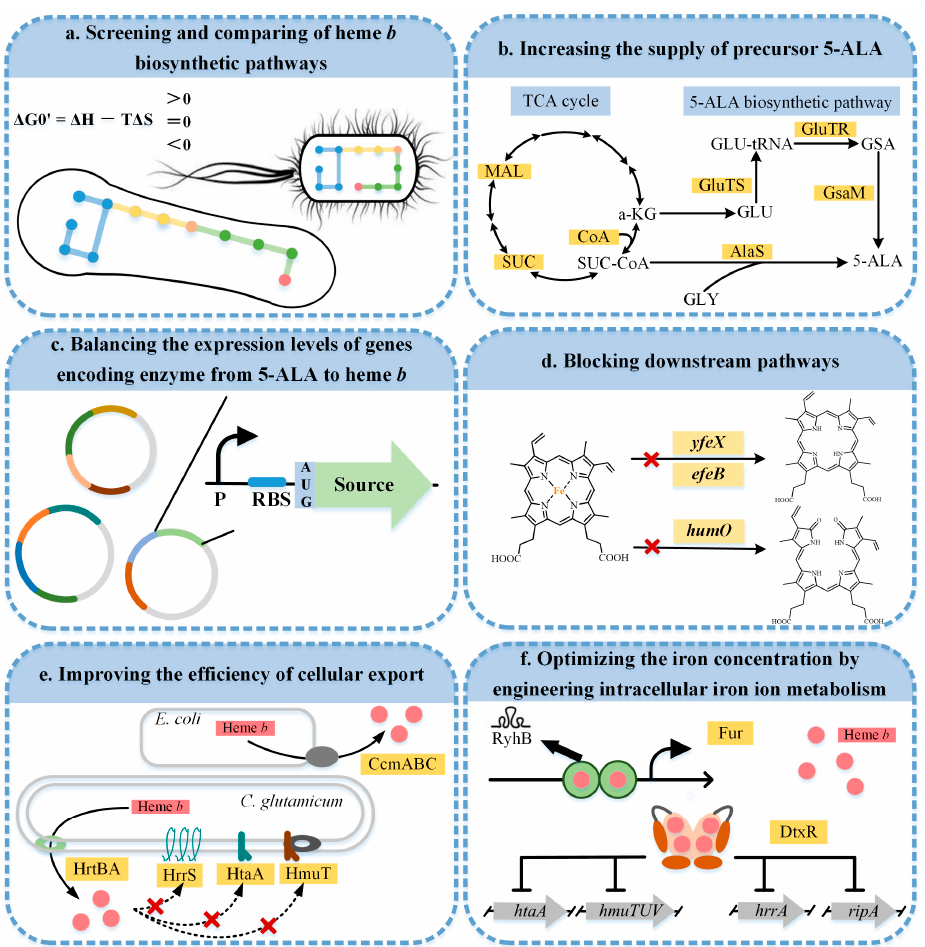
Figure 4. Metabolic engineering strategies for the heme b biosynthesis. A red cross indicates that the corresponding pathway is blocked. MAL, malate; SUC, succinate; SUC-COA, succinyl-CoA; CoA, coenzyme A; α -KG, α -oxoglutarate; GLY, glycine; GLU, glutamate; GLU-tRNA, glutamyl-tRNA; GSA, glutamate-1-semialdehyde; 5-ALA, 5-aminolevulinic acid; GluTS, glutamyl-tRNA synthetase; GluTR, glutamyl-tRNA reductase; GsaM, glutamate-1-semialdehyde-2,1-aminomutase; AlaS, 5-aminolevulinic acid synthase; HmuO, heme oxygenase; Ccm ABC, cytochrome c export protein; HrtBA, heme regulated transporter A and B; Fur, ferric uptake regulator; DtxR, diphtheria toxin repressor.